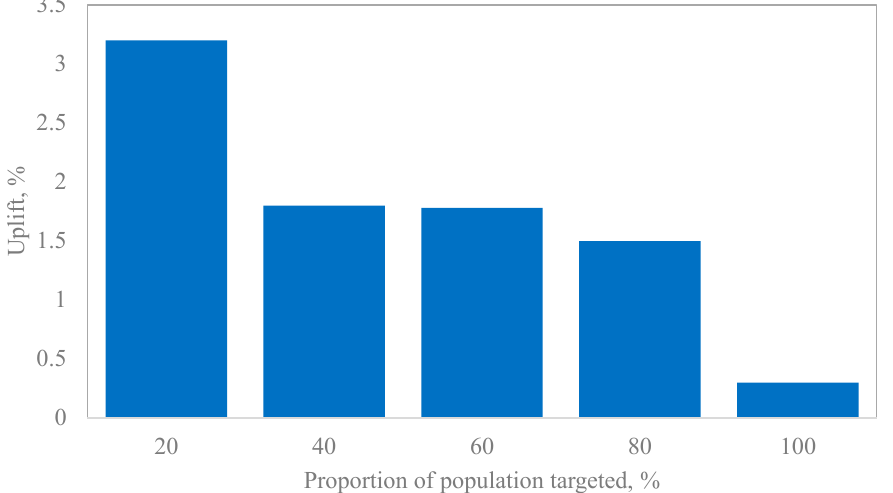
Figure 5. Uplift versus proportion of population targeted.